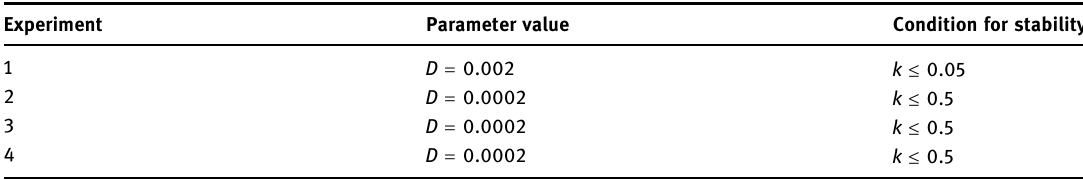
Table 1: Range of values of k for stability of FTCS scheme with = h 0.02